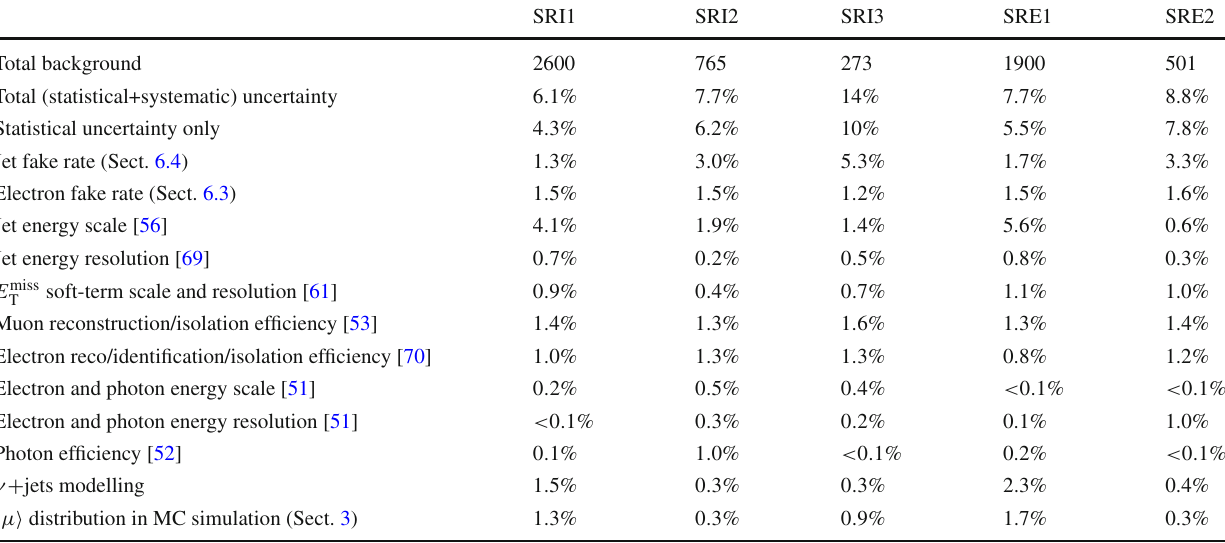
Table6 Breakdownoftherelevantuncertaintiesinthebackgroundesti- mates for all SRs. The uncertainties are given relative to the expected total background yield after the inclusive-SR fit for SRI1, SRI2 and SRI3 and after the multiple-bin fit for SRE1 and SRE2. The total statis-